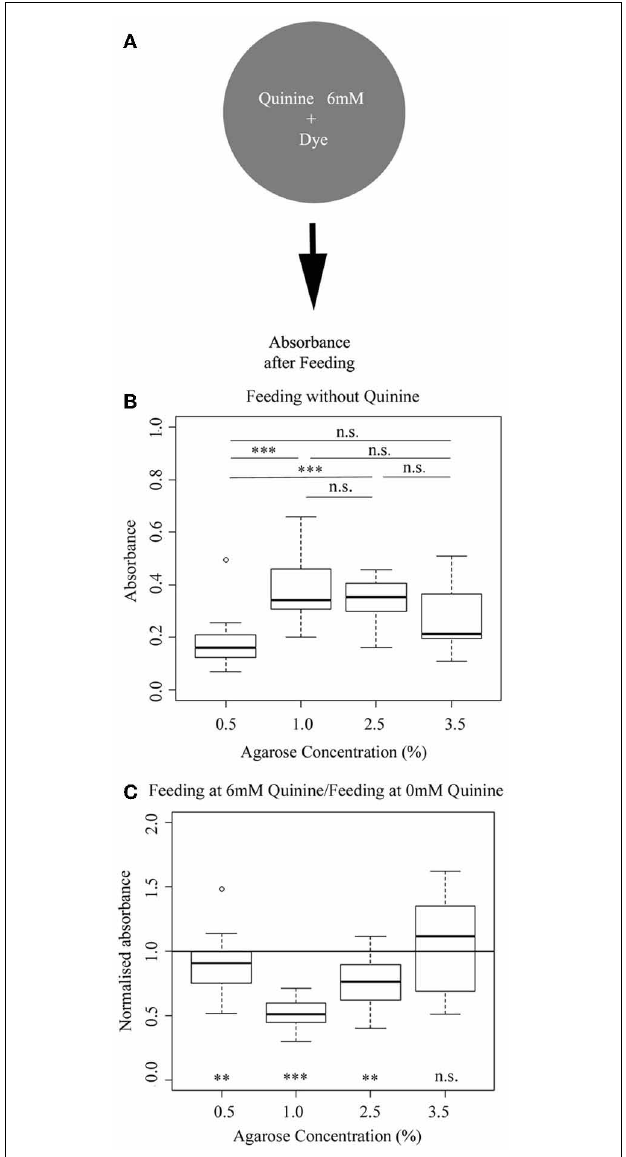
FIGURE 4 | Larval feeding depends on the concentration of the agarose substrate. (A) Overview of the experimental setup to test for larval feeding. (B) Wild-type larvae show different feeding rates for 0.5, 1.0, 2.5, and 3.5% of agarose. At 0.5% agarose, feeding is lower than feeding on 1.0% agarose ( p < 0 . 001) and 2.5% ( p < 0 . 001). Feeding at 3.5% agarose is on an intermediate level that is not significantly to any of the other three groups ( p > 0 . 05). Differences between individual groups are shown above the box-plots. (C) Adding of 6mM quinine to agarose concentrations tends to reduce feeding compared to the behavior on pure agarose (here visualized by the normalized scores for 6mM quinine feeding divided by pure agarose feeding). However, the effect is limited to agarose concentrations of 0.5%, 1.0 and 2.5% as only at these concentrations the normalized values are below the baseline feeding observed when the larvae are fed on pure agarose (indicated by 1.0 for normalized absorbance; p < 0 . 01, p < 0 . 001, p < 0 . 01 and p > 0 . 05 for 0.5, 1.0, 2.5, and 3.5%, respectively). A significant difference for each group against normalized absorbance at 1.0 is shown below each box-plot. Sample size n > 12 for each group. Small circles indicate outliers. ∗∗∗ p < 0 . 001; ∗∗ p < 0 . 01; n.s., not